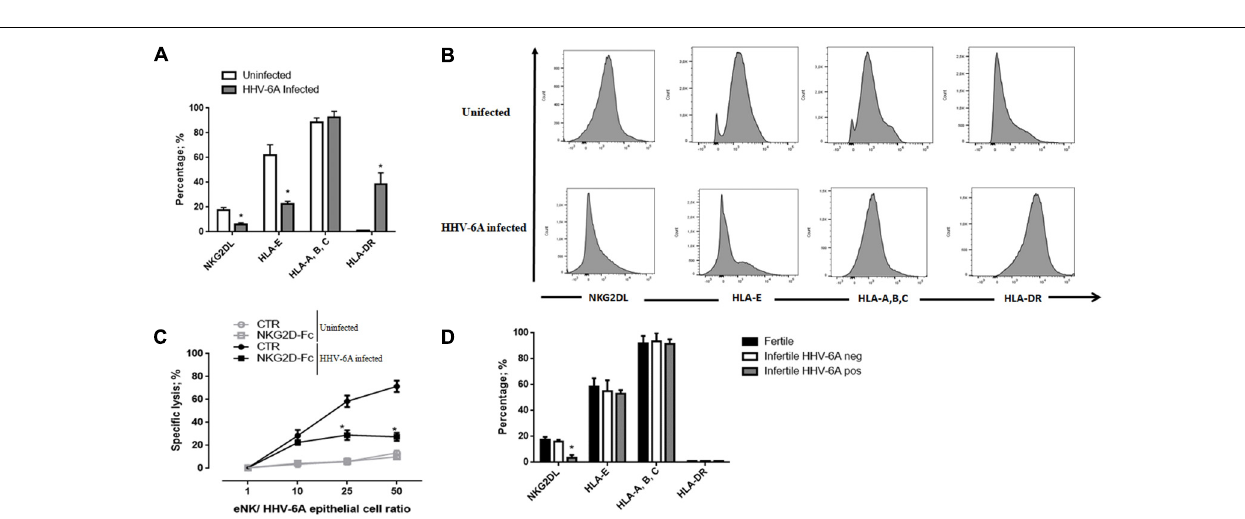
FIGURE 5 | Functional analysis dNK cells specific receptors. (A,B) HHV-6A-infection modulates the expression of NKR ligands on endometrial epithelial cells. The binding of human NKG2D-Fc chimera was used to evaluate the cell surface expression of specific receptor ligands. The expression of HLA-E and HLA-A, -B, -C and HLA-DR molecules was evaluated using specific mAb. (C) Endometrial epithelial cells uninfected (gray lines) or infected (black lines) were incubated with soluble NKG2D-Fc fusion protein at the concentration of 1 mg/ml and eNK cell cytotoxicity was analyzed by 7-AAD/CFSE Cell- Mediated Cytotoxicity Assay Kit after 18 h of co-culture. (D) The expression of NKG2D ligands, NKG2A ligands (HLA-E and HLA-A, -B, -C) and HLA-DR expression on the surface of endometrial epithelial cells from fertile women and HHV-6A positive and negative infertile women. Data sets represent mean lysis ± SD from five independent experiments done in replicate. ∗ Significant p -value; Student’s t